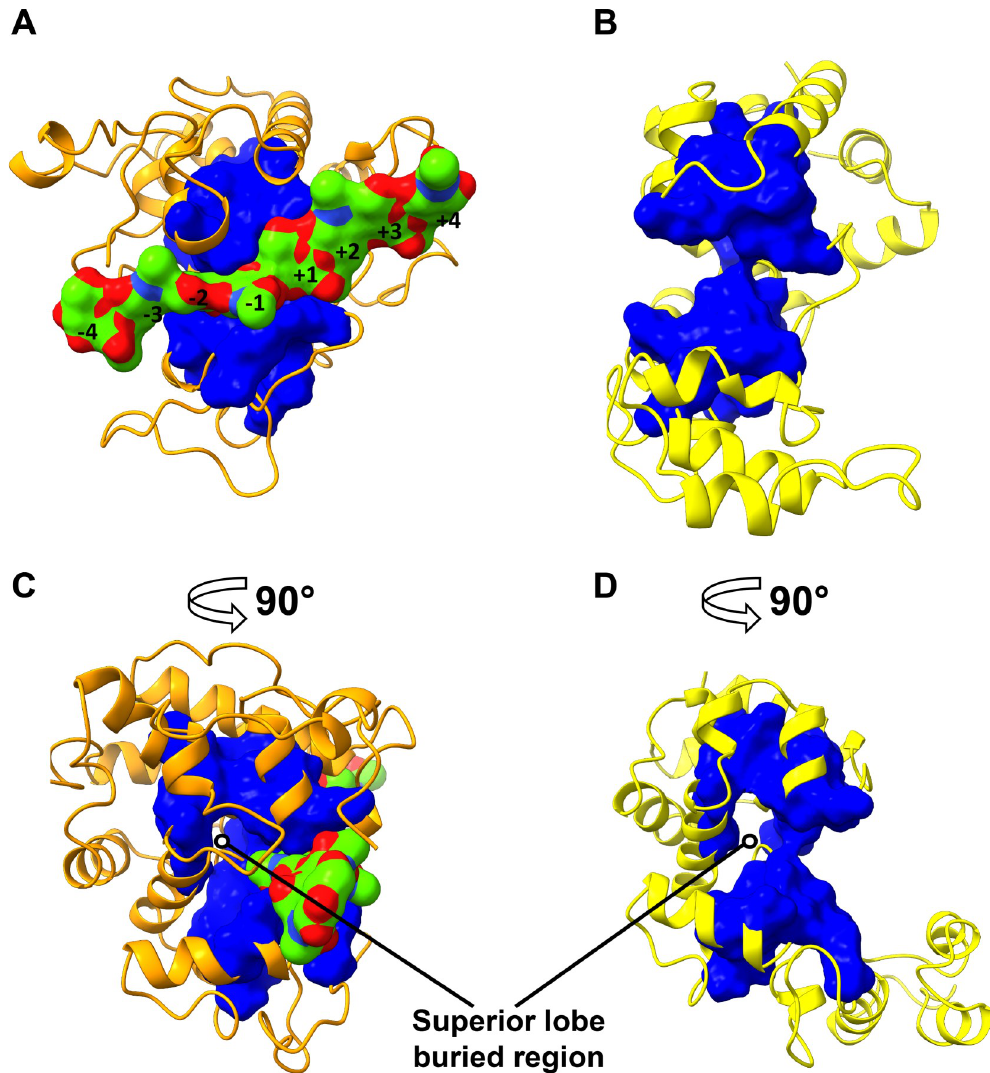
Fig 4. The most conserved and structurally aligned positions between CHITs and ELYSs (reported in Table 1). The solvent accessible surface of these positions is plotted onto the reference models of CHIT ( A ) and ELYS ( B ) subfamilies (PDB accessions 4j0l of “loopful” plant chitinase from rye seed Secale cereale , and 4ok7 of bacteriophage SPN1S endolysin from Salmonella typhimurium , respectively), represented in cartoon style. In ( C ) and ( D ), the same models are rotated by 90˚ around the vertical